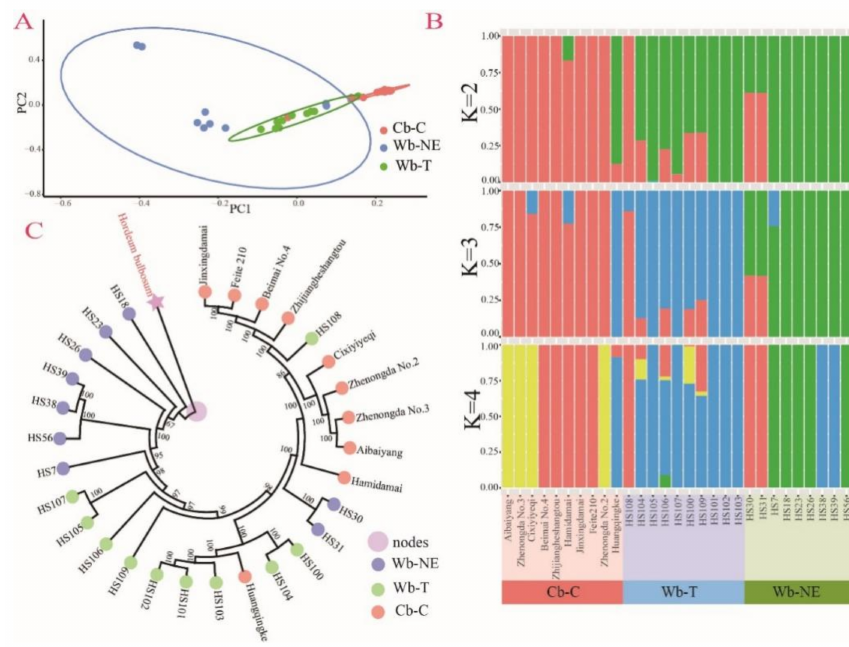
Figure 1. PCA scatter plot, population structure and rooted phylogenetic tree of 29 barley accessions representing three typical groups. Wb-NE, wild barley from the Near East Fertile Crescent. Wb-T, wild barley from the Tibetan Plateau. Cb-C, cultivated barley from China. ( A ) PCA scatter plot was visualized based on the PC1 (the first principal component) and PC2 (the second principal component). ( B ) Population structure of three barley groups when K was 2, 3, and 4, respectively. ( C ) Rooted phylogenetic tree of 29 barley accessions with H. bulbosum as an